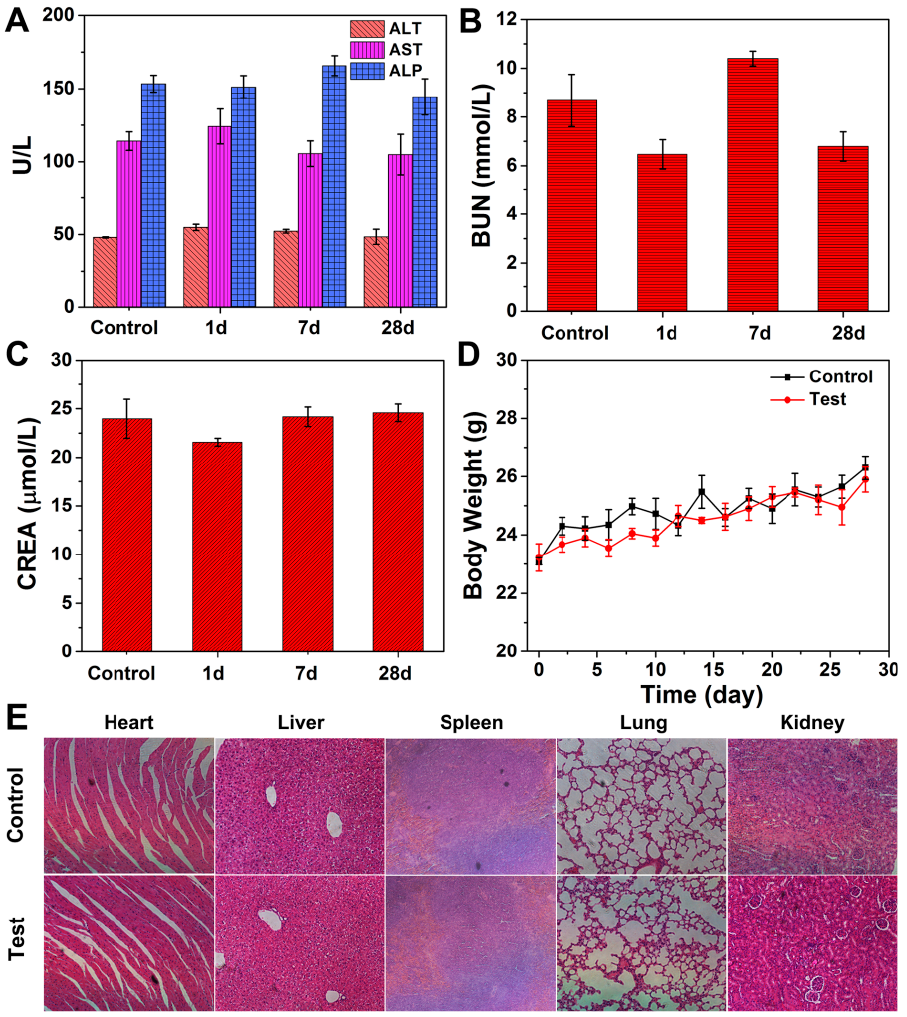
Figure 6. ( A – C ) Blood serum biochemistry data of healthy Balb/c mice with intravenous injection of NV-p@BSA NPs. The data were collected at different time points (1st, 7th, and 28th days post- injection). ( D ) Body weight change of Balb/c mice treated with NV-p@BSA NPs within 28 days compared to the control group without any injection. ( E ) H&E-stained histological slices from mice receiving no injection (control) or mice injected with NV-p@BSA NPs (test) at the 28th day post- injection.